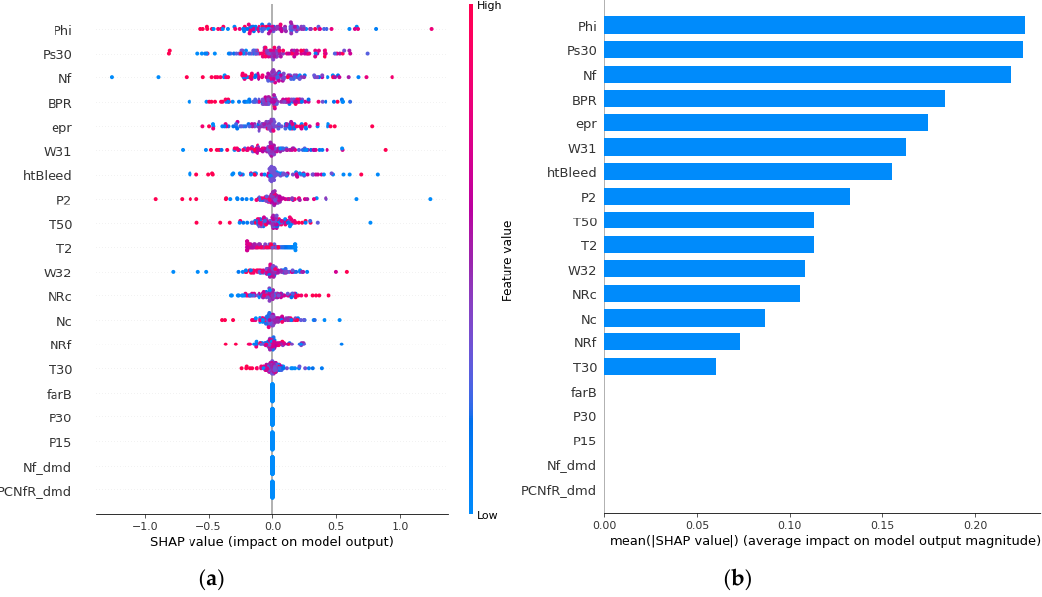
Figure 8. ( a ) SHAP summary plot (point) and ( b ) SHAP summary plot (absolute value).